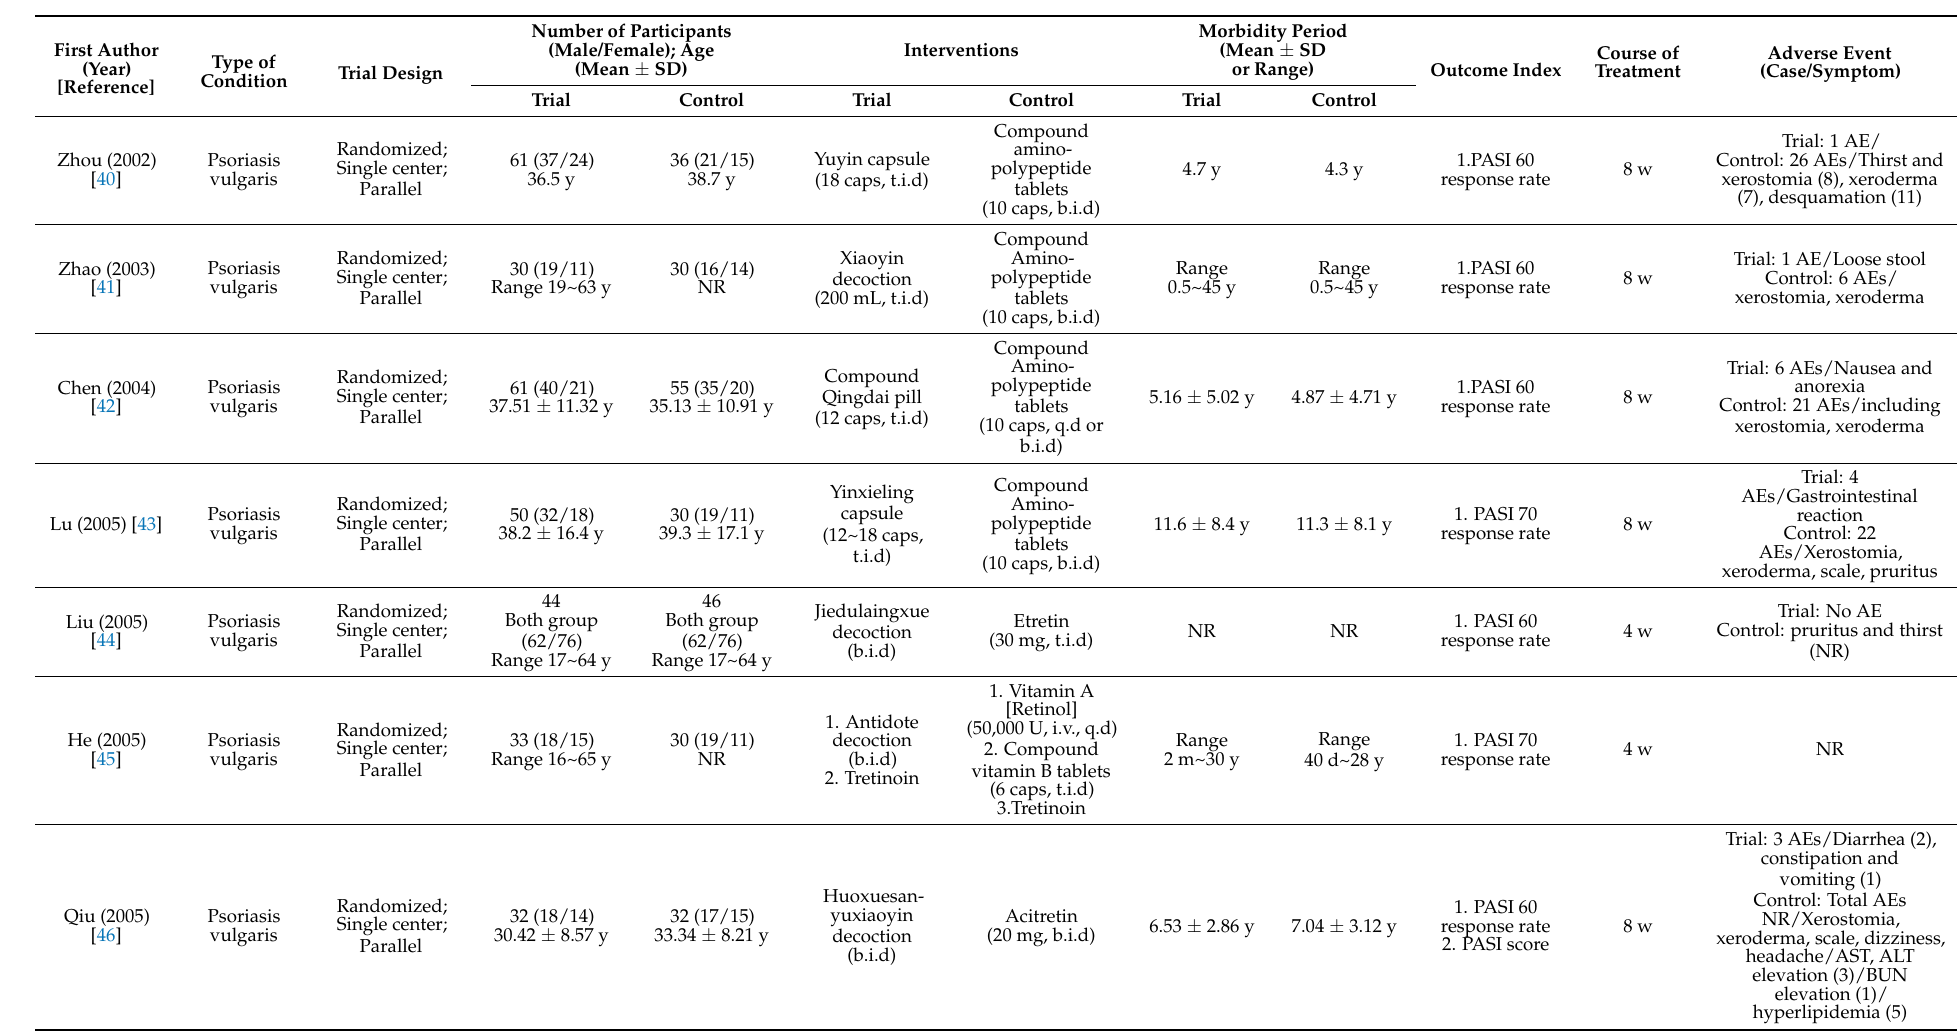
Table 1. Characteristics of included